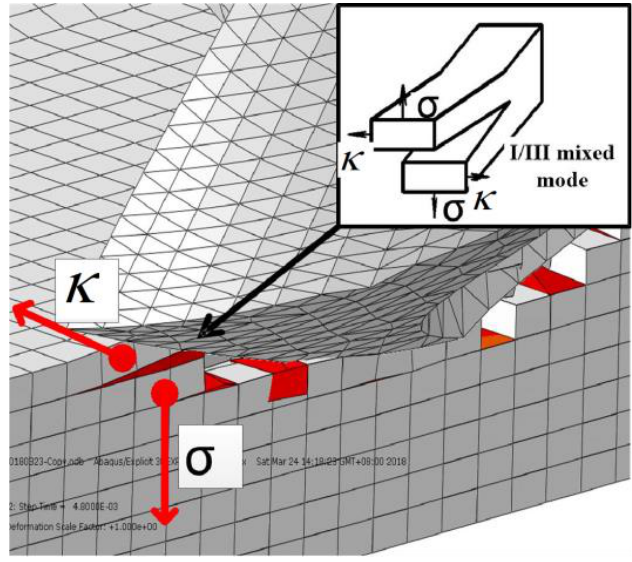
Figure 6. Crack form of main cutting edge at drilling inlet.